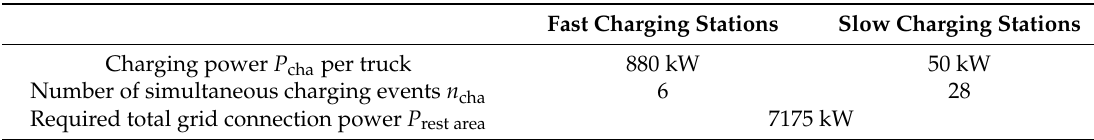
Table 5. Average rest area with charging infrastructure for